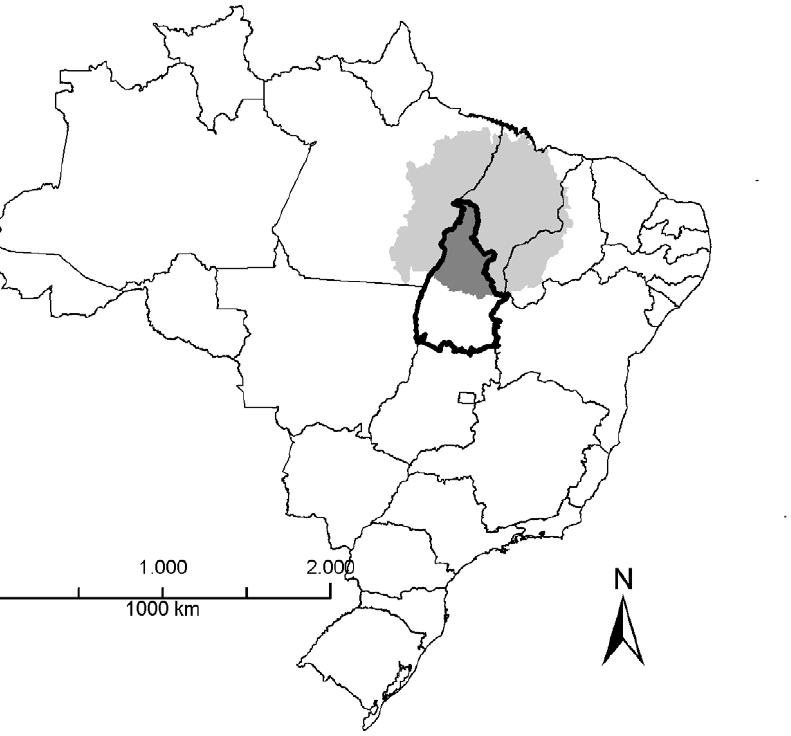
Figure 1. Study area (dark gray area) in Tocantins State, Brazil. The light gray area indicates the cluster of high transmission risk situated in the states Maranha˜o, Para´, Tocantins and Piauı´.